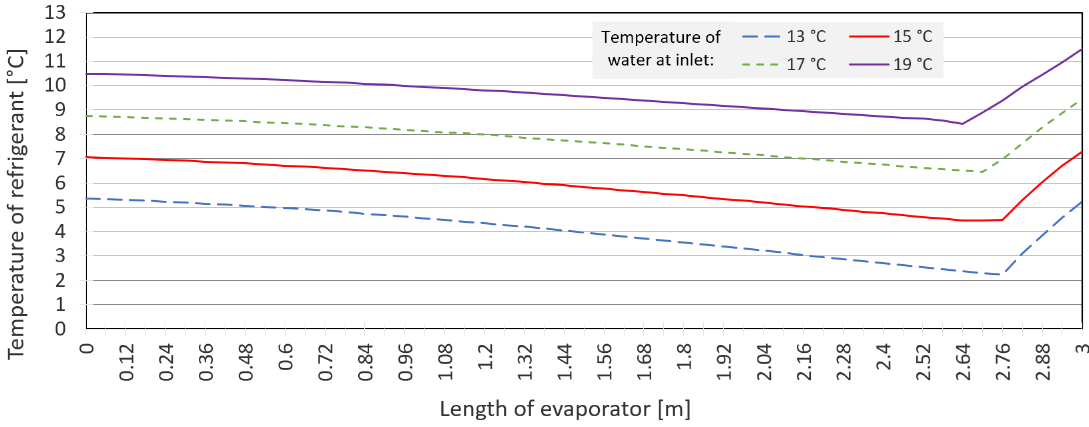
Figure 10. The temperature of the refrigerant.